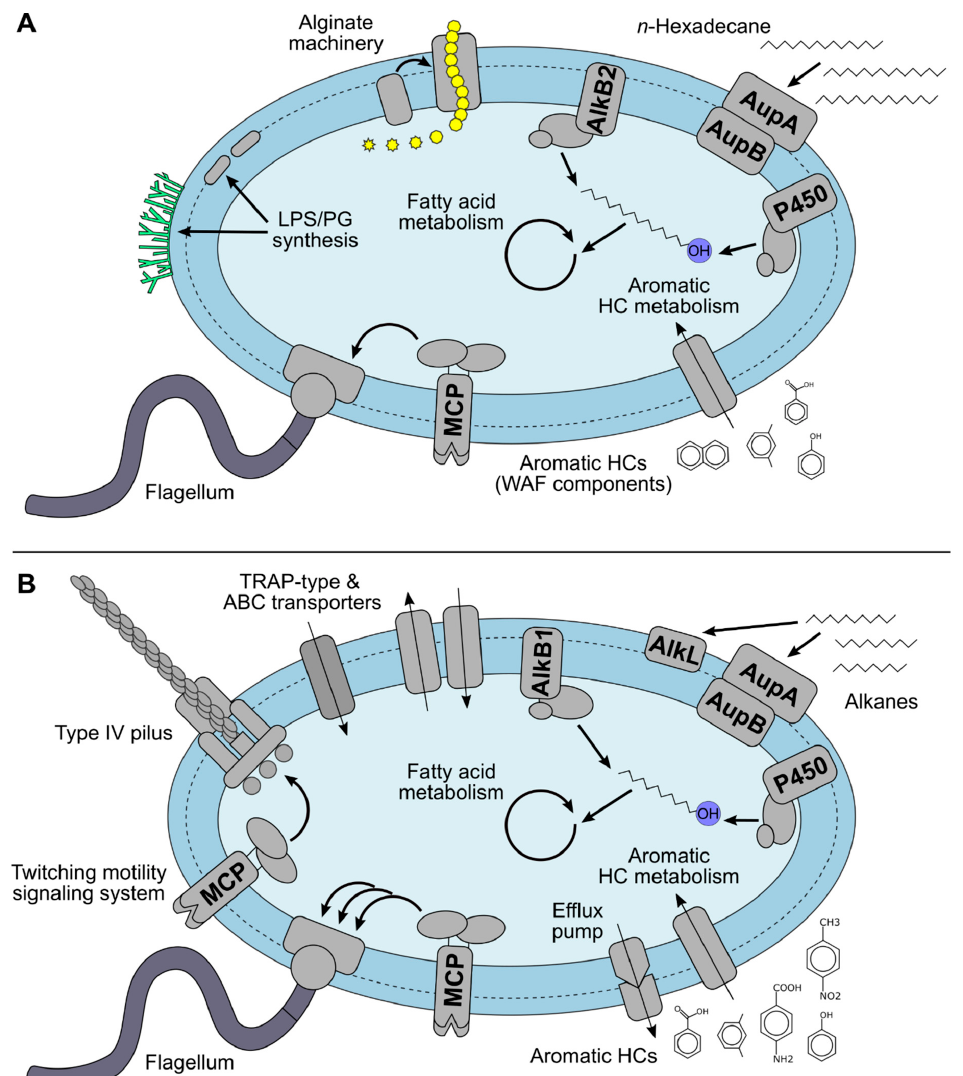
Figure 3. Schematic overview of the metabolism of Marinobacter sp. TT1 when ( A ) utilizing hydrocarbons ( n -hexadecane or WAF), or ( B ) growing on components of Corexit and/or with Corexit exposure. Abbreviations: LPS = lipopolysaccharide, PG = peptidoglycan, HC = hydrocarbon, WAF = water-accommodated fraction, MCP = methyl-accepting chemotaxis protein, TRAP = tripartite ATP-independent periplasmic, ABC = ATP-binding cassette. See Table S9 for protein names.